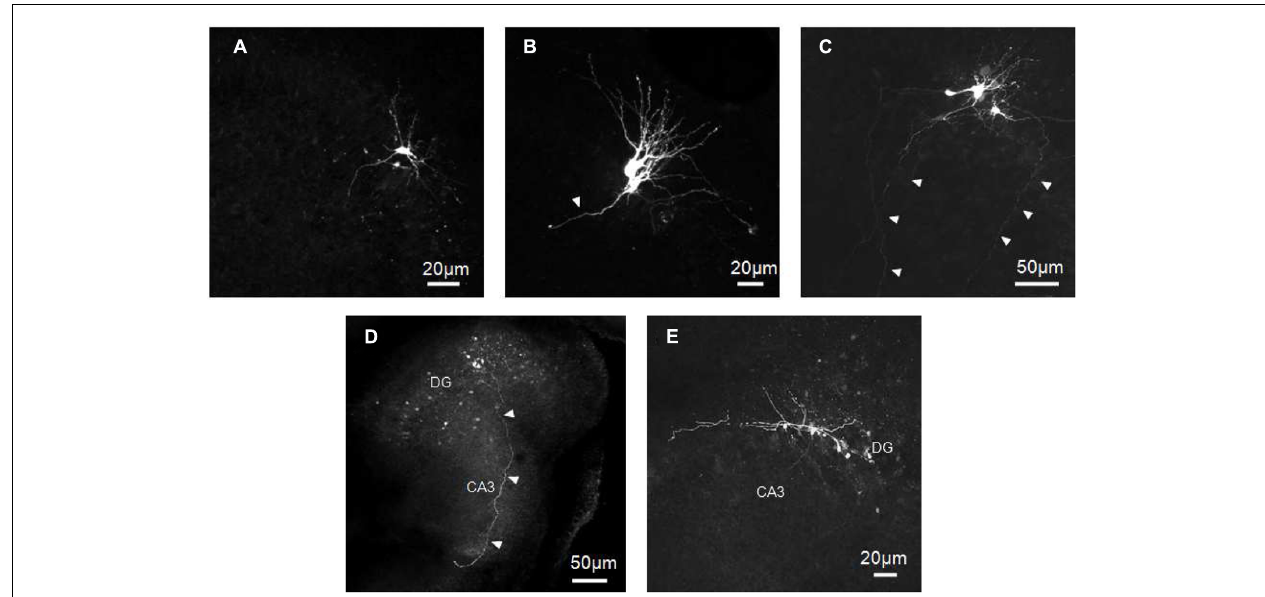
FIGURE 2 | Biocytin-labeled GCs at P0–P2. GCs exhibit small cell bodies with few short and tick dendrites oriented toward the molecular layer (A–C) and/or running tangentially to the GC layer (C,E) . Dendrites often display small